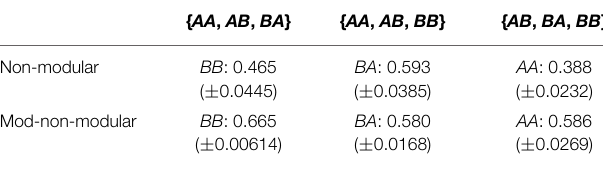
TABLE 2 | Mean values of the error for the non-modular robot in the unseen environment after achieving an error of at most 0.15 in the three seen environments